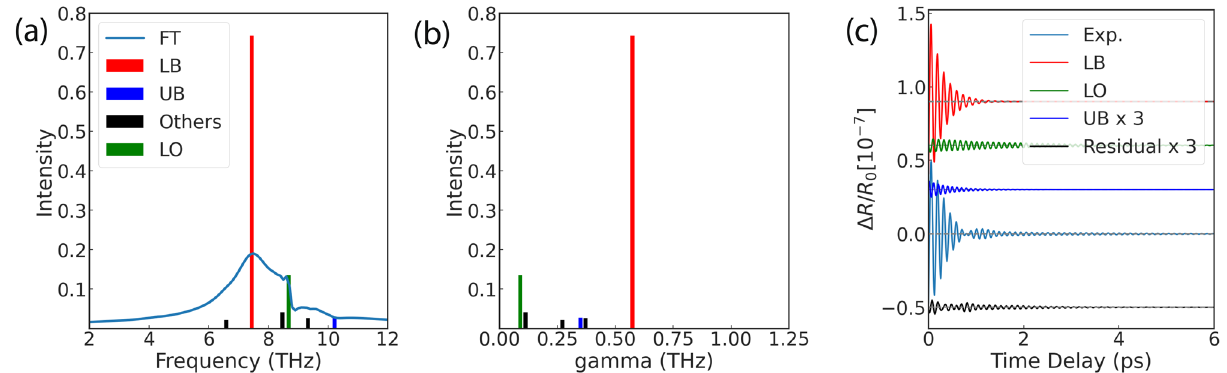
Figure 3. The spectra for the case of n exe = 5.72 × 10 17 cm − 3 . ( a ) The results of frequencies. The horizontal axis shows the frequencies, and the vertical axis shows the intensity of each mode of DMD and Fourier spectrum. The black bars indicate the discrete modes obtained by DMD. The green, red, and blue bars indicate the modes corresponding to the LO, LB, and UB modes, respectively, of the black DMD mode. The solid light blue line shows the Fourier spectrum. ( b ) The results of dumping rate ˜ γ . The horizontal axis shows γ , and the vertical axis shows the strength of the DMD mode. Modes selected in ( a ) are colored in the same way. ( c ) Result of restoring the original signal format for each modes. As in ( a ) and ( b ), each mode is color-coded. The solid black lines show the residuals of the sum of the three selected modes and the experimental signal. To visualize the vibration components, we tripled the amplitudes of the UB and